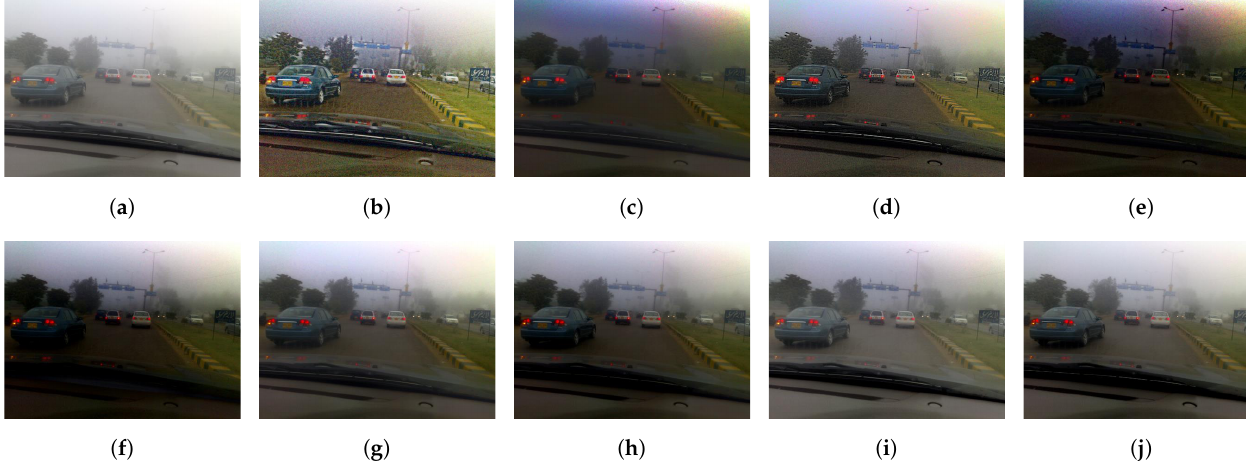
Figure 21. A qualitative comparison of different dehazing methods on a real hazy image of a road scene. ( a ) Hazy image, and results by ( b ) Tarel and Hautiere [35], ( c ) He et al. [21], ( d ) Kim et al. [36], ( e ) Bui and Kim [50], ( f ) Zhu et al. [52], ( g ) Ngo et al. [74], ( h ) Cai et al. [85], ( i ) Ren et al. [89], and ( j ) the proposed